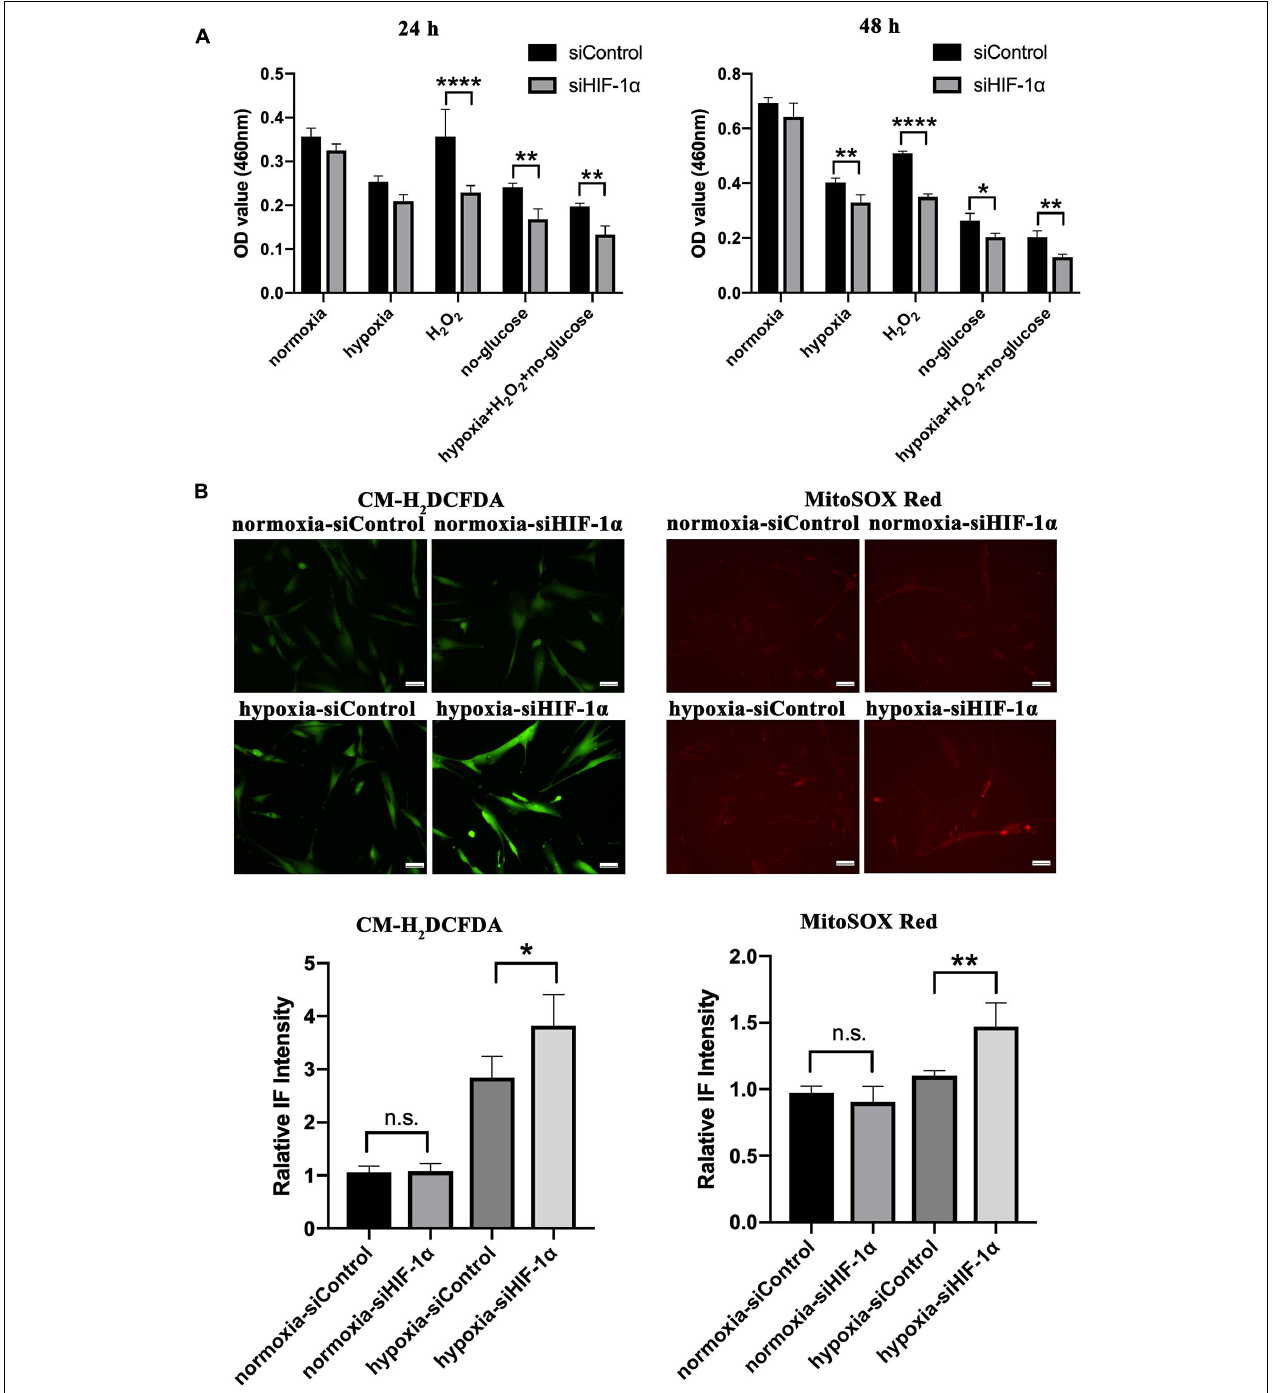
FIGURE 4 | Silencing HIF-1 α in SHED limits their cell viability and ROS homeostasis under stress in vitro. (A) CCK-8 assay of siControl and siHIF-1 α SHED in normoxia, hypoxia, H 2 O 2 , glucose deprived medium, and hypoxia + H 2 O 2 + glucose-deprived medium. (B) Immunofluorescence for CM-H 2 DCFDA (green) and MitoSOX (red) showed the cytoplasmic and mitochondrial ROS levels in SHED, respectively. * p < 0.05, ** p < 0.01, and **** p < 0.0001. Scale bar = 50 µ m.